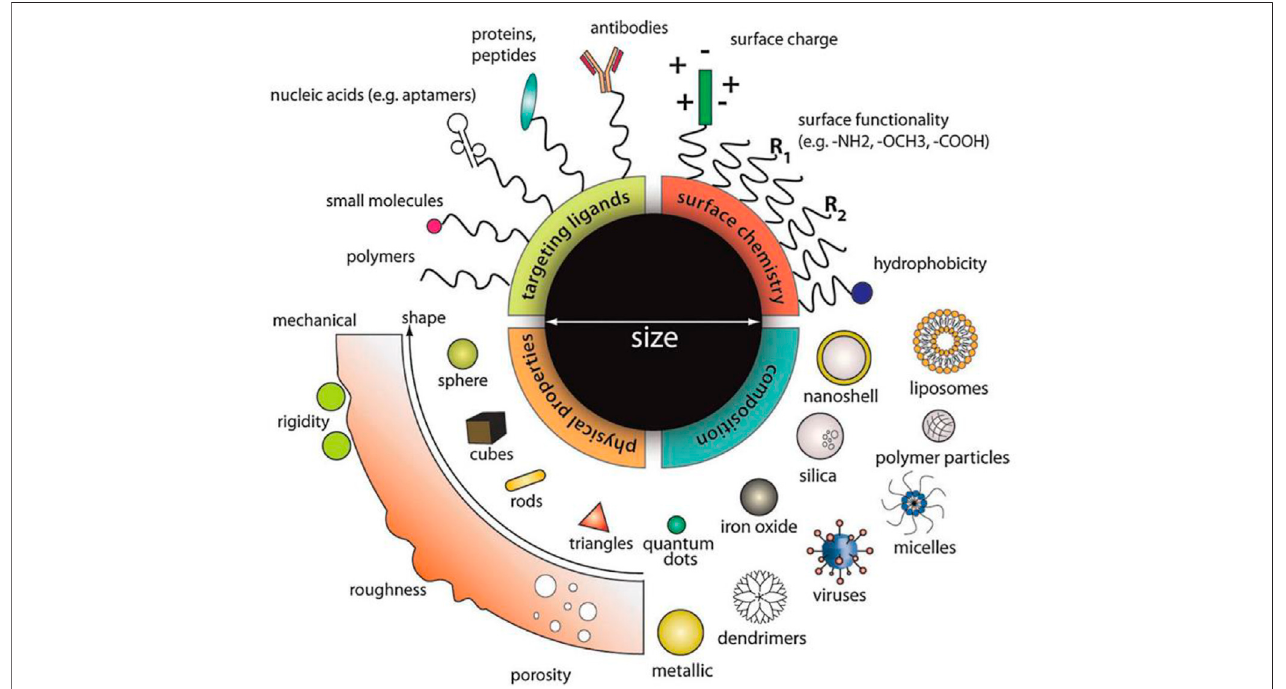
FIGURE 4 | Designing multifunction nanoparticles for ideal treatment requirement. Material composition, surface properties, and molecule size can all be considered to optimize the functional properties of nanoparticles, including drug loading, release kinetics, cellular uptake, biological stability, and many more. Reprinted with permission from Chou et al.